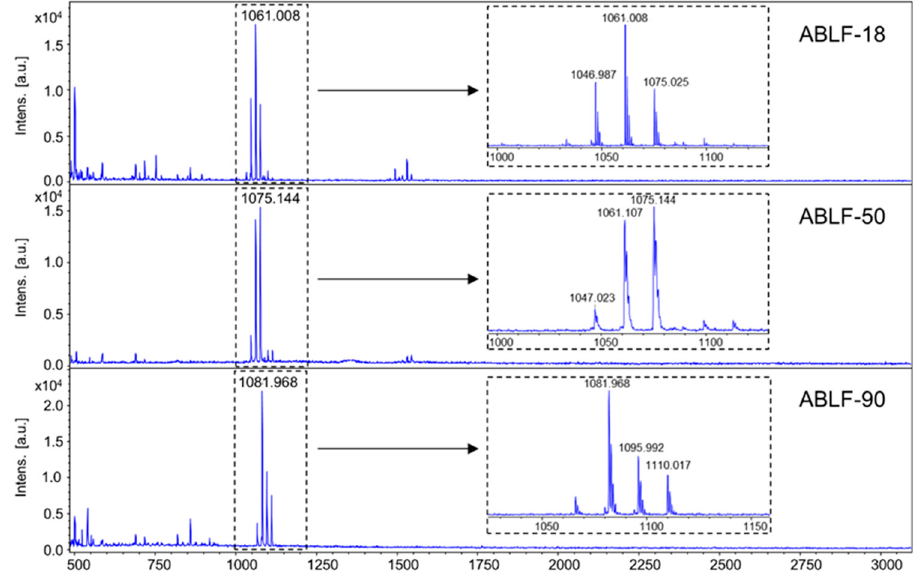
Figure 5. MALDI-ToF MS spectra of Bacillus sp. ABLF-18, Bacillus sp. ABLF-50, and Paenibacillus sp. ABLF-90.